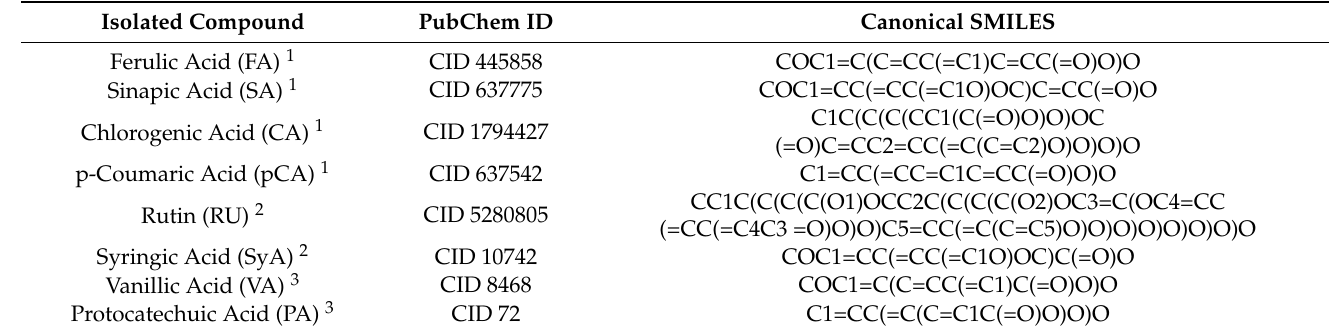
Table 2. Reported compounds isolated from MH leaves